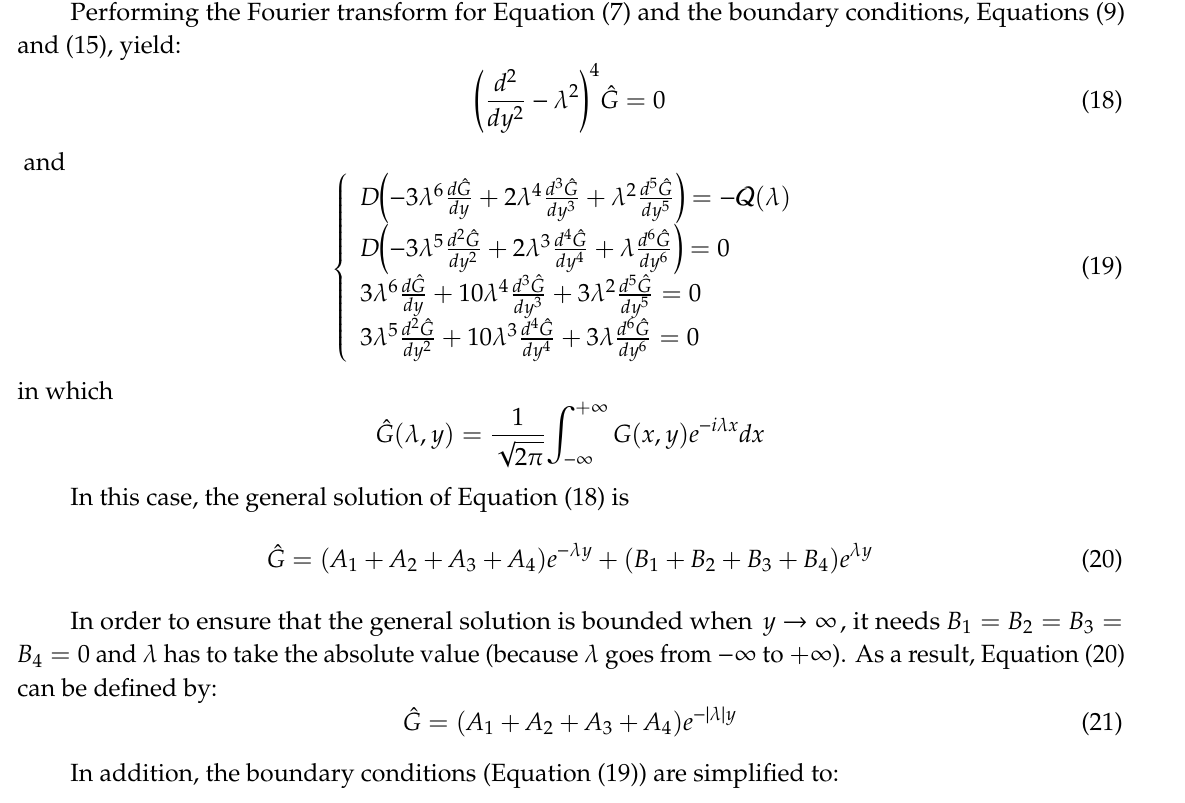
Figure 1. A schematic figure for semi-infinite plane of quasicrystals.